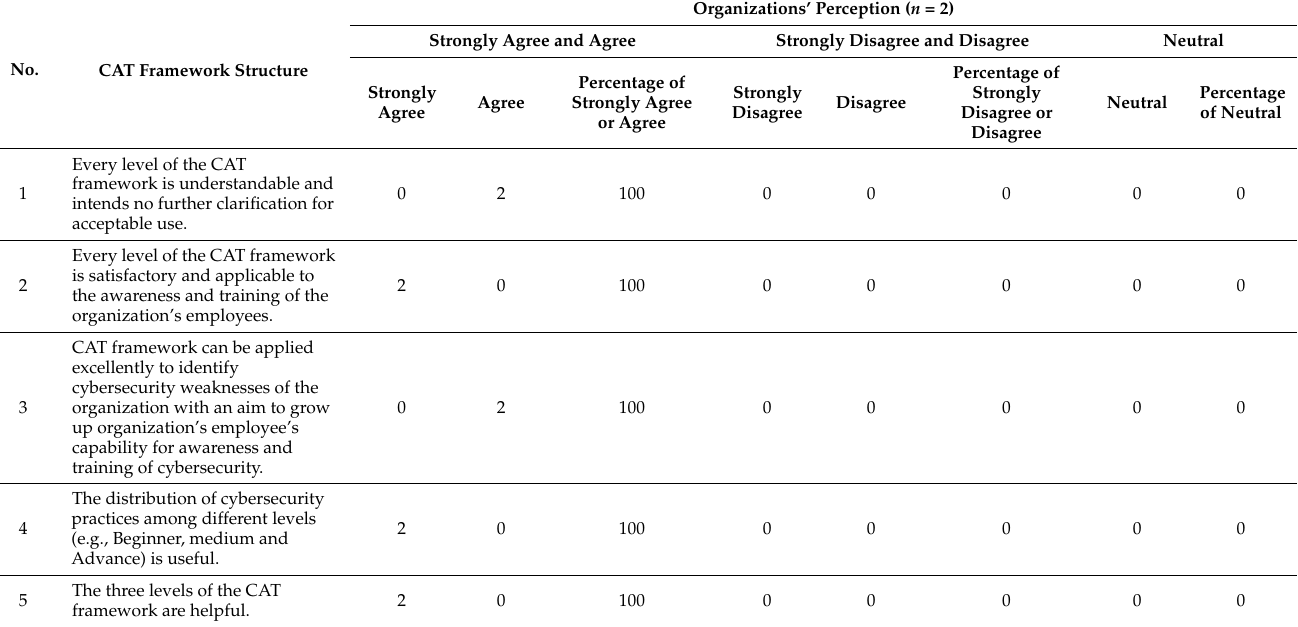
Table 5. CAT framework structure evaluation from both organization I and organization II.